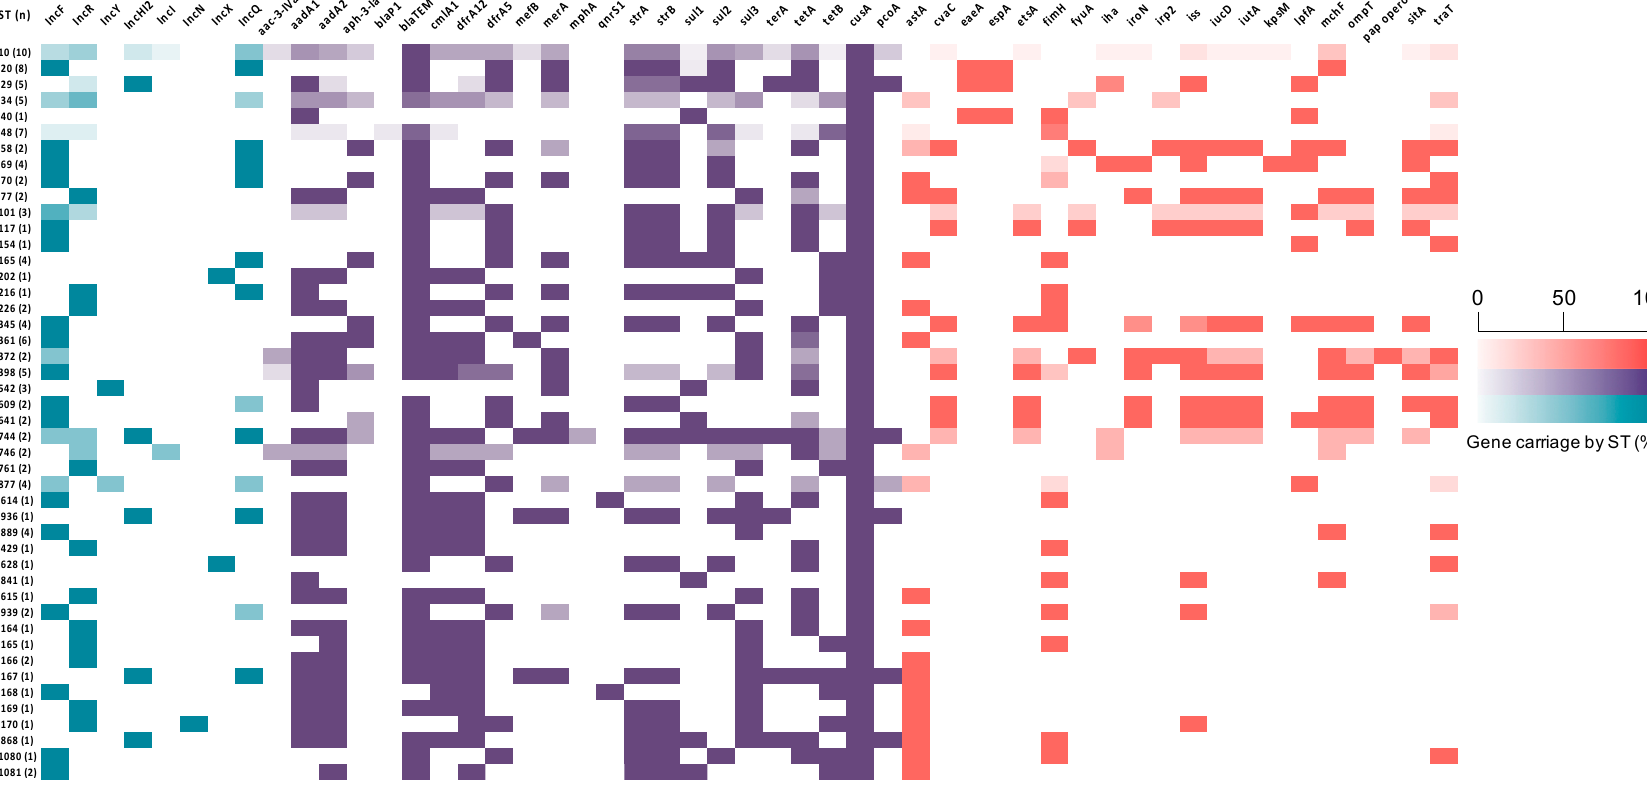
Figure 2. Heat map showing proportion of sequence types (STs) carrying plasmid replicons (aqua), antimicrobial resistance genes (purple) and virulence-associated genes (red). For the full dataset see Supplementary Tables S2–S4.